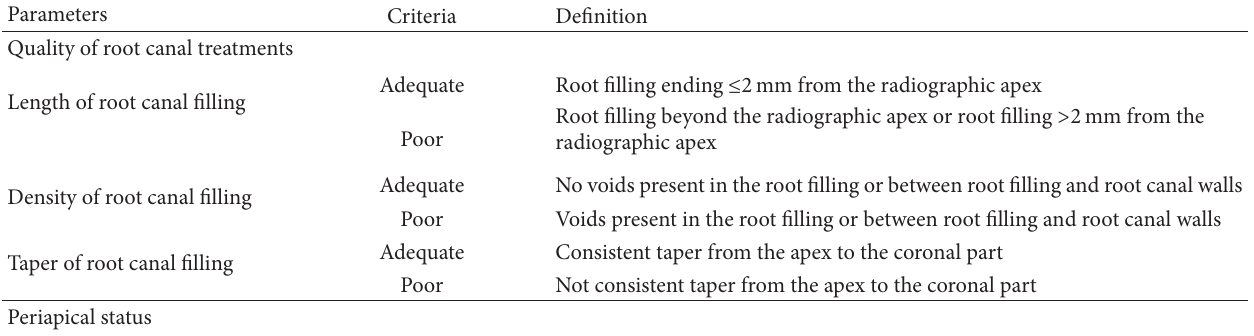
Table 1: Parameters recorded on endodontically treated